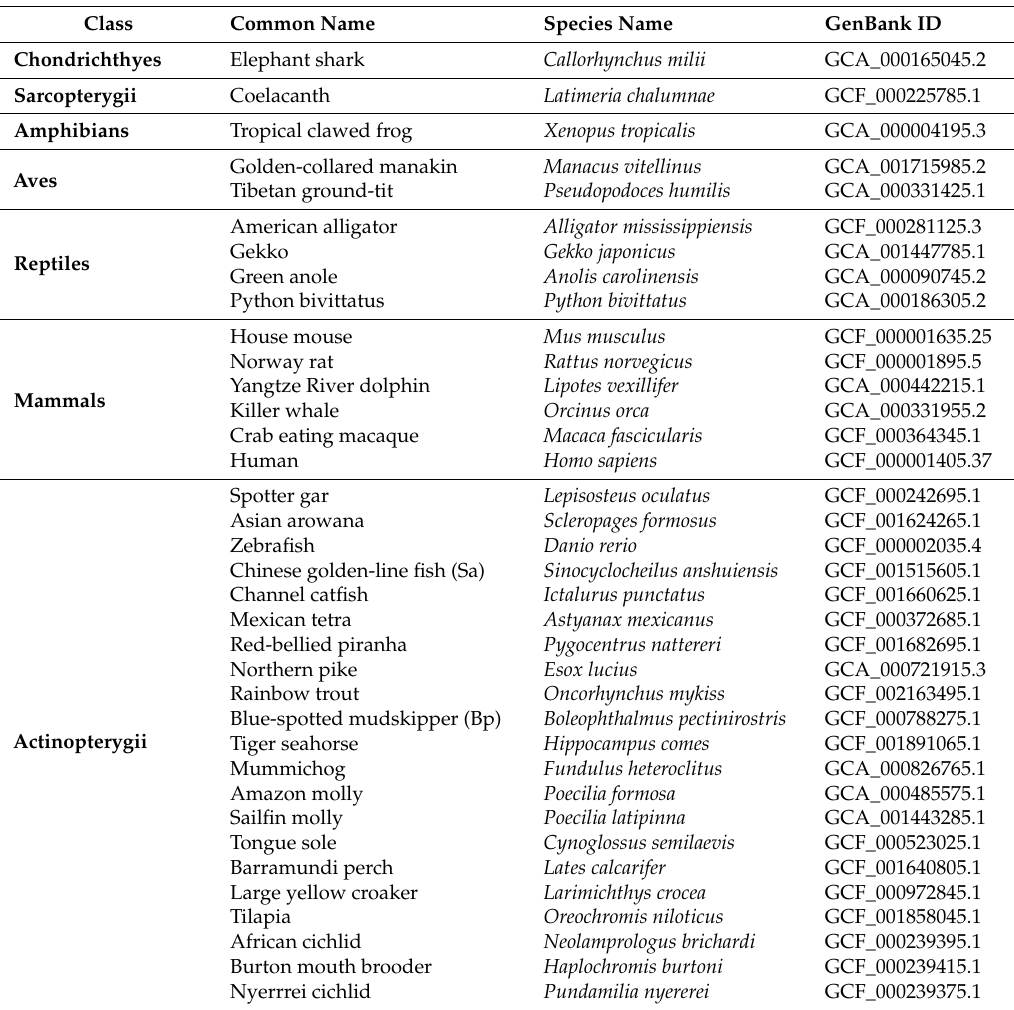
Table 1. Selected 36 vertebrates and corresponding Genebank ID for their sequenced